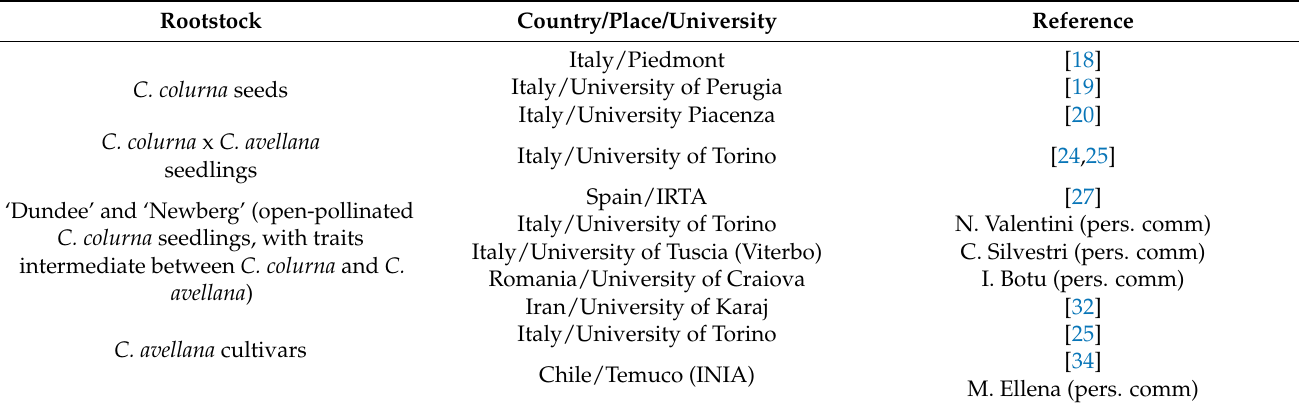
Table 2. Current trials of hazelnut rootstocks in five